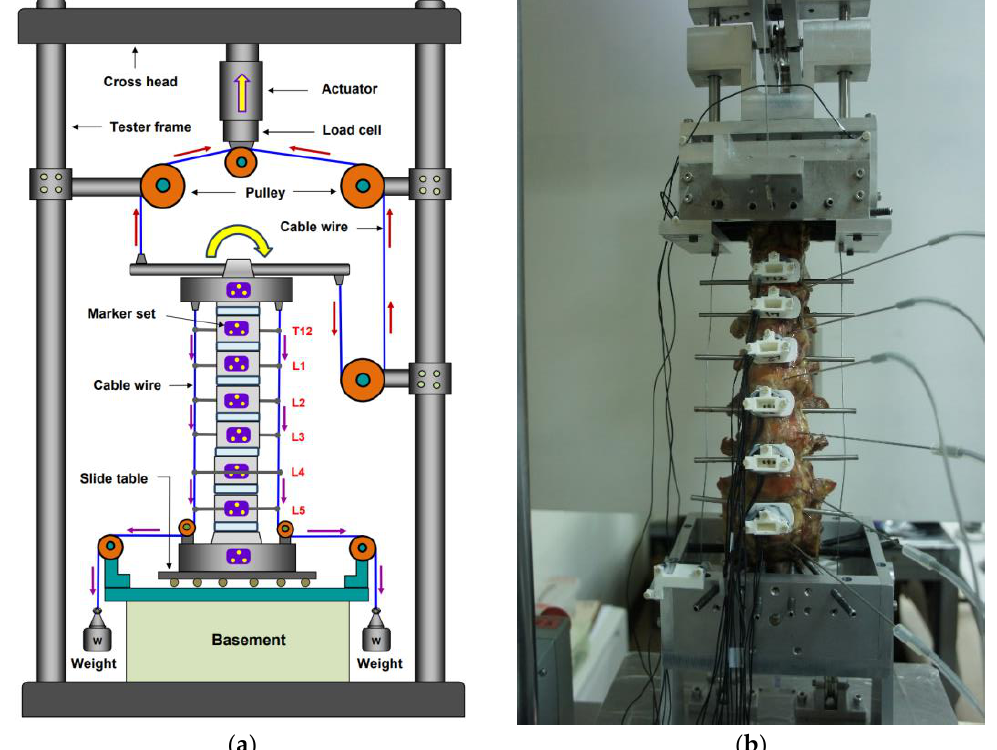
Figure 3. Schematic of the experimental setup: ( a ) a cable–pulley system was installed on the specimen to produce the pure moment, and the follower load was applied along the cable wires bilaterally by eyelets which were mounted laterally onto the vertebra; ( b ) Plexiglass marker sets were installed on the vertebra bodies (T12–L5).